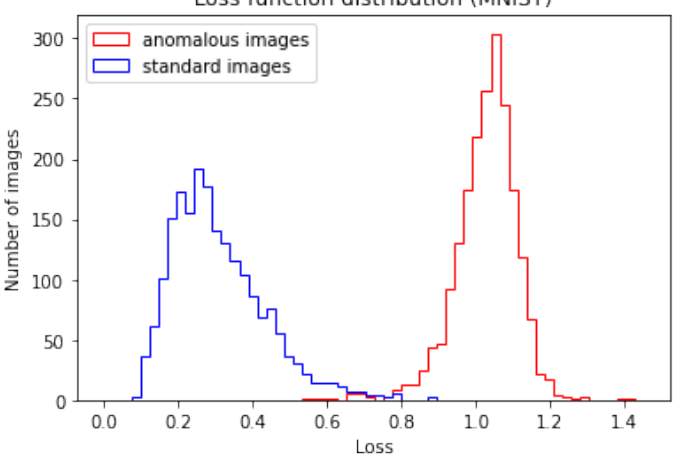
Figure 6. Quantum autoencoder loss function values distribution. The graph was made using 2000 normal data images (zeros) and 2000 anomalous data images (ones) from the MNIST